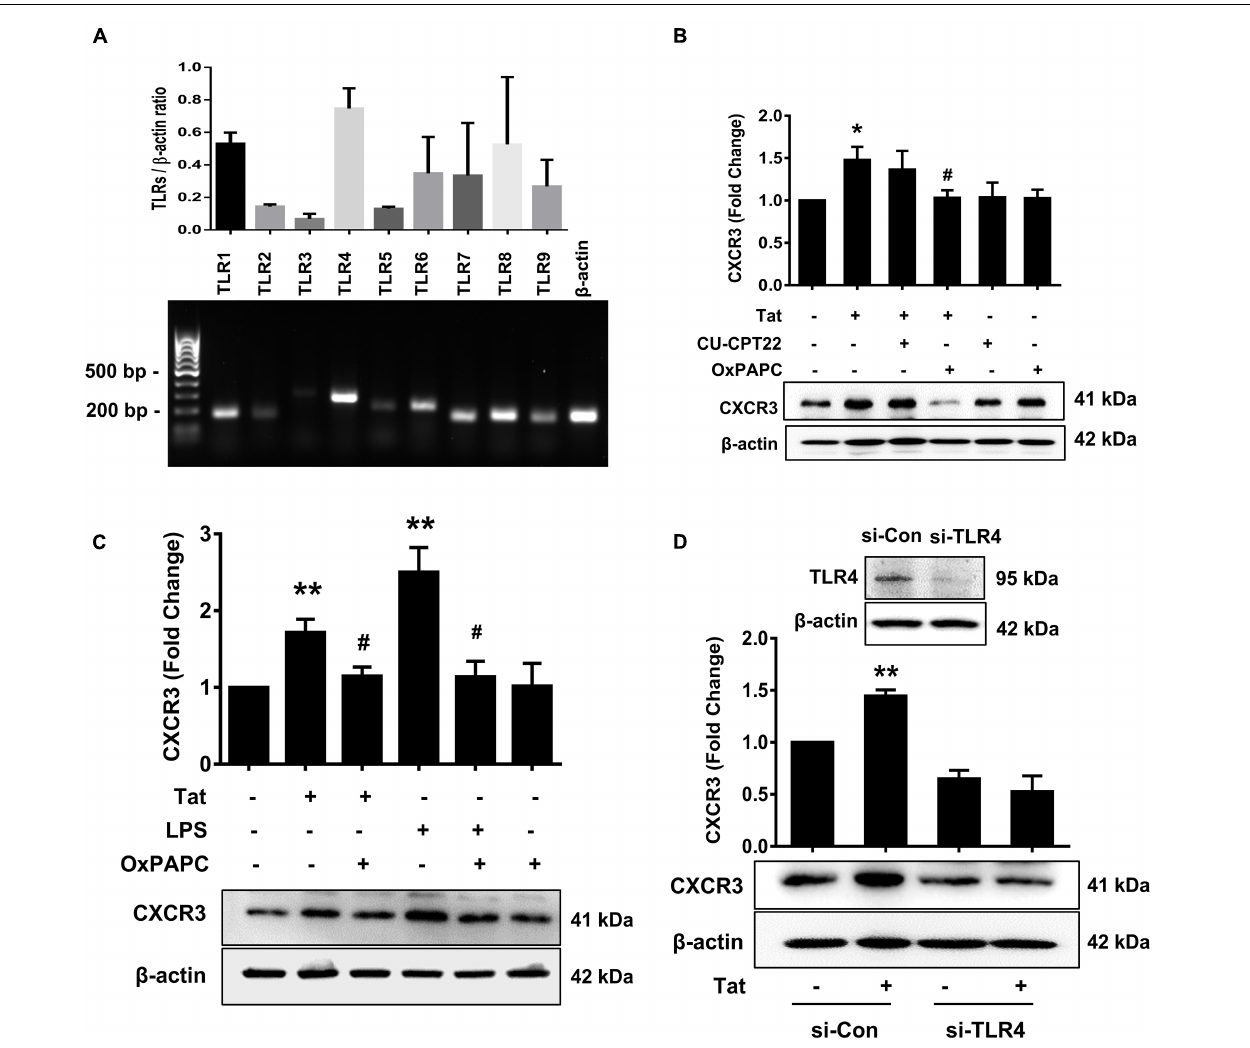
FIGURE 3 | Involvement of TLR4 in HIV Tat-mediated upregulation of CXCR3 expression. (A) Comparative expression of TLR1 - TLR9 mRNA levels by RT-PCR analysis in human monocytes. (B) Representative Western blot and quantification of CXCR3 in the cell lysates from human monocytes pretreated with selective TLR1/2 inhibitor CU CPT22 (1 µ M) and TLR2/4 inhibitor OxPAPC (30 µ g/ml), followed by HIV Tat exposure for 24 h. N = 4. (C) Representative Western blot and quantification of CXCR3 in the cell lysates from human monocytes pretreated with TLR2/4 inhibitor OxPAPC (30 µ g/ml), followed by LPS (100 ng/ml) or HIV Tat exposure for 24 h. N = 4. (D) Representative Western blot of silencing of TLR4 in human monocytes transfected with TLR4 siRNA (si-TLR4). Representative Western blot and quantification of CXCR3 in the cell lysates from human monocytes transfected with TLR4 siRNA and nonsense siRNA transfected controls (si-Con) followed by HIV Tat exposure. One-way ANOVA with post hoc test. N = 3. All data are presented as mean ± SD of three or four individual experiments (Biological replicates). * p < 0.05 versus control group; ** p < 0.01 versus control group; # p < 0.05 versus HIV Tat or LPS